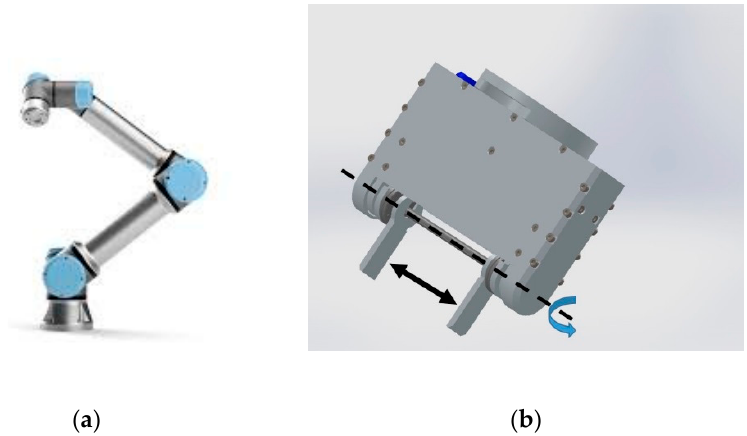
Figure 7. ( a ) UR5e Robot manipulator ( b ) Parallel gripper with 2-dof of fingers. Both fingers of the parallel gripper can simultaneously rotate about the axis of rotation shown as dotted line. Both fingers can also translate simultaneously to grasp and release the part. Table 1. DH parameters of UR5e robot